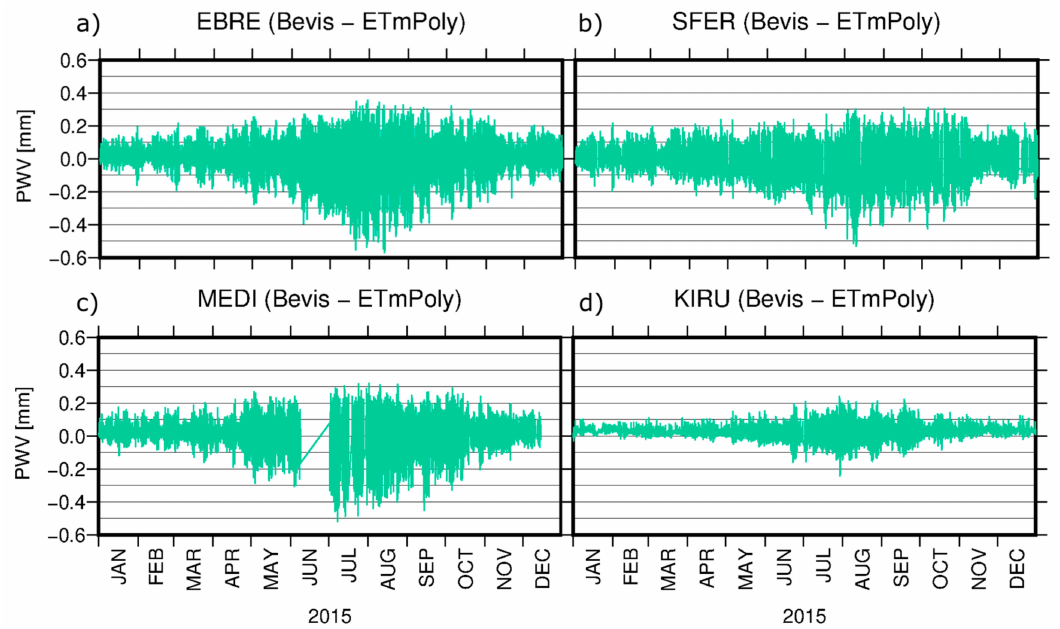
Figure 8. Di ff erences between PWV values estimated using Bevis and ETmPoly coe ffi cients for EBRE ( a ), SFER ( b ), MEDI ( c ), and KIRU ( d ) GNSS